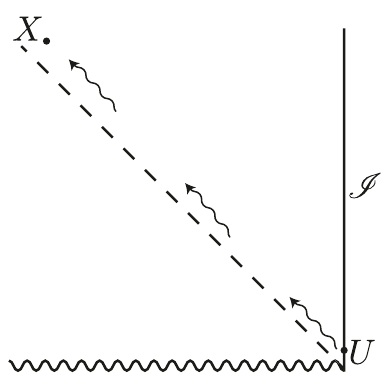
Figure 1 . Example showing how causal connection between I and its HRT surface X can be used to change S vN with a local